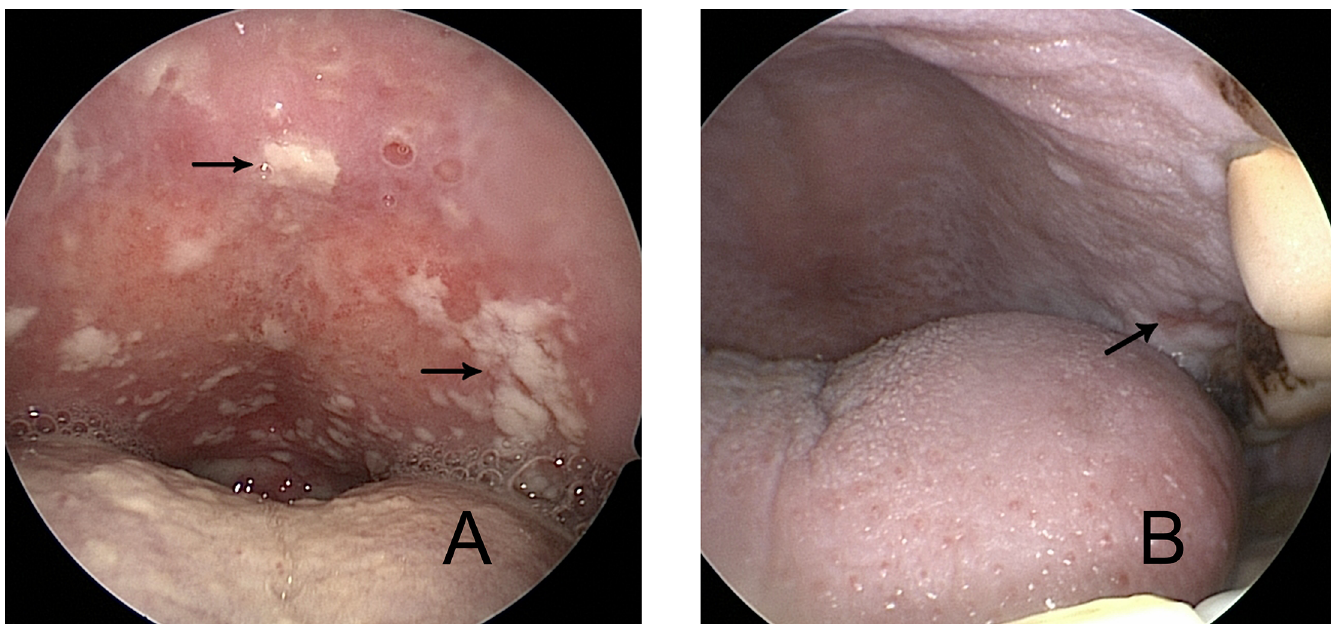
Fig 1. Oral candidiasis, 51-year-old female, after the 18th fraction of radiotherapy in the OPC group. Whitish pseudomembranes and drops (arrows) are observedon the hard palate, which is devoidof mucositis (A). Mucositis grade 2 to 3, 57-year-old male, after the 25th fraction of radiotherapy in the non- OPC group. Confluentpseudomembranes and patchy ulcerations (arrow) can be observed